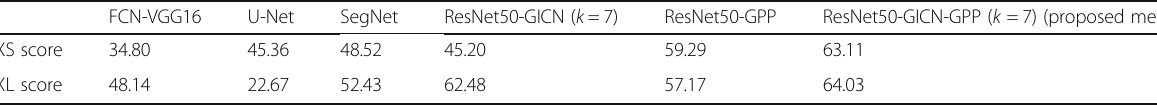
Table 4 Segmentation accuracy of model to multi-scale